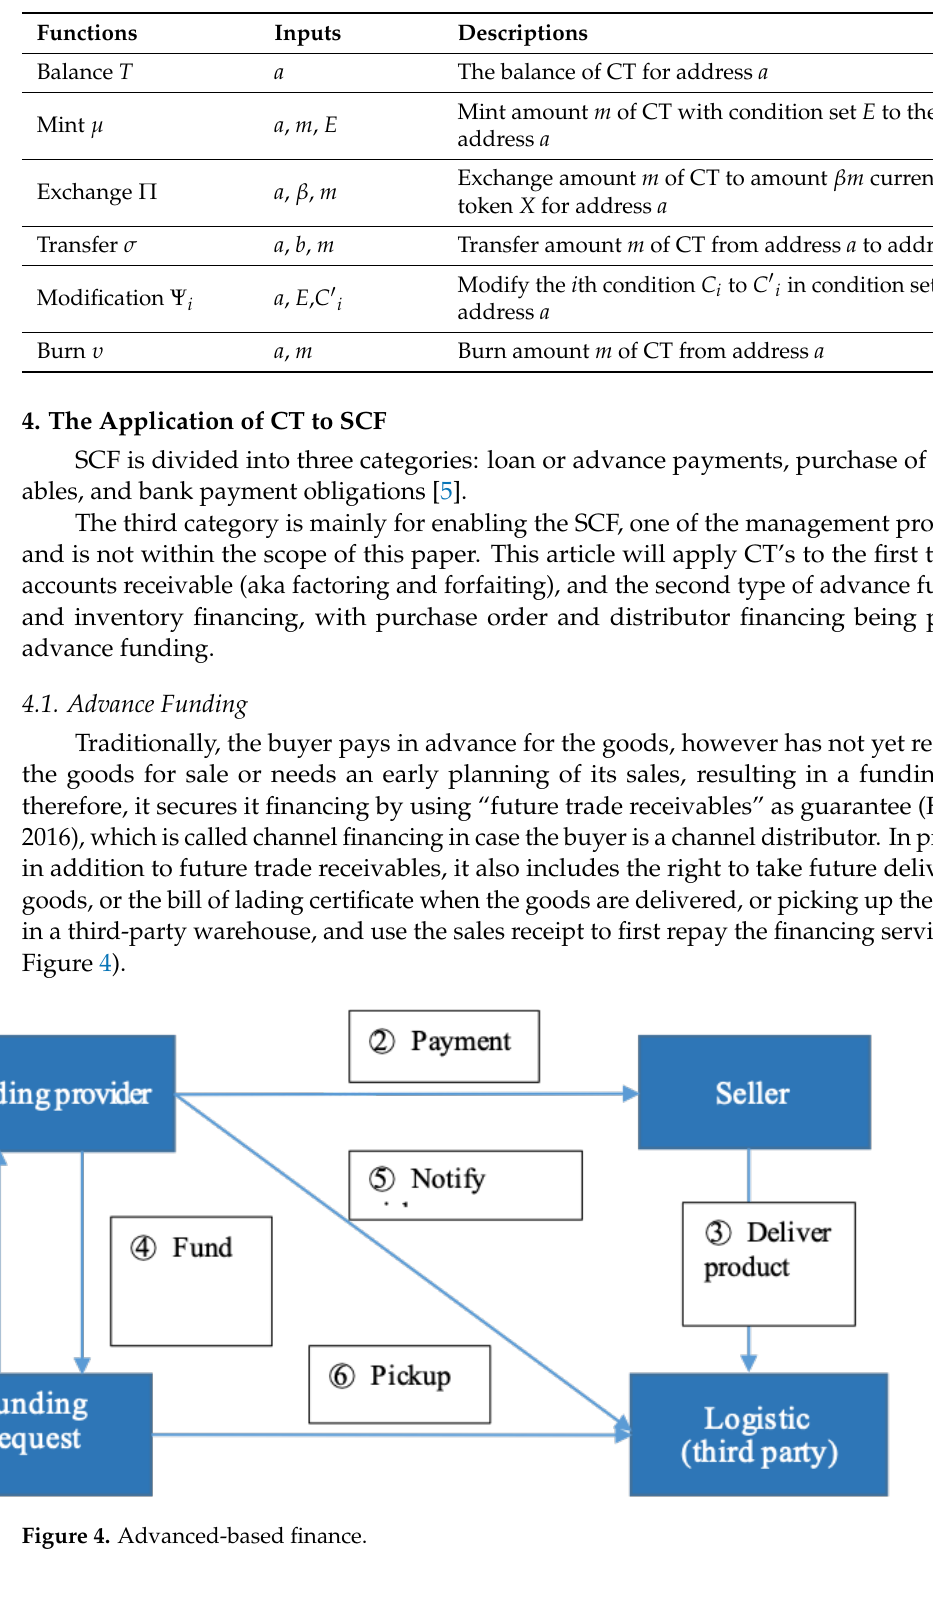
Table 2. The functions/operations of CT.